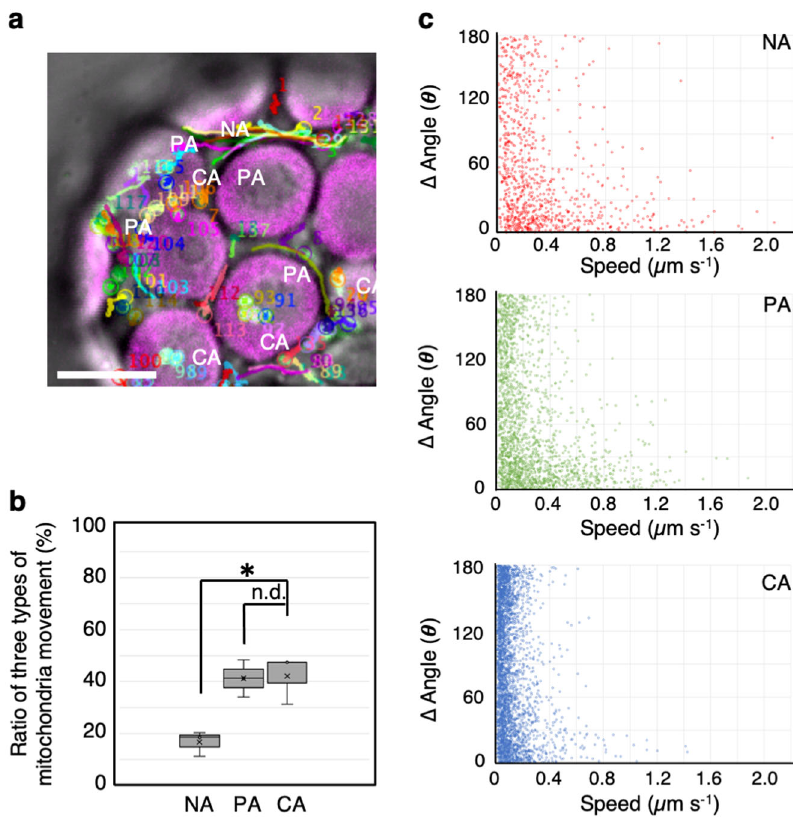
Fig. 7 Mitochondrial movement is in fl uenced by association with chloroplasts. a CLSM image representing three types of mitochondrial movements: no association (NA), partial association (PA), and continuous association (CA) with chloroplasts. Trajectories of mitochondrial movement constructed from time-lapse analysis of images acquired at 30-s at 250-ms intervals. Scale bar: 10 µ m. ** P < 0.01, n.d. P > 0.05 (Student ’ s t test). N.d. no difference. b Ratio of mitochondrial movement classi fi ed as having NA, PA, and CA with chloroplasts. c Scatter plot of speed ( x -axis) and angle changes ( y -axis) of three different types of mitochondrial movements, including, NA (red), PA (green), and CA (blue) at each time point acquired from the trajectories of mitochondrial movement in three different